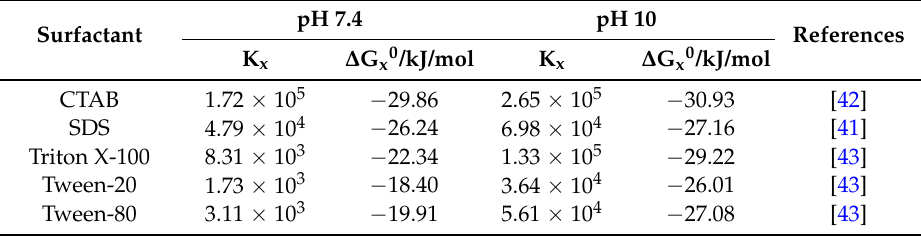
Table 3. Partition coefficients (K x ) and the standard free energy change for the transfer of mitoxantrone from bulk water to micellar phase ( ∆ G x0 ) for the interaction of mitoxantrone with different surfactant